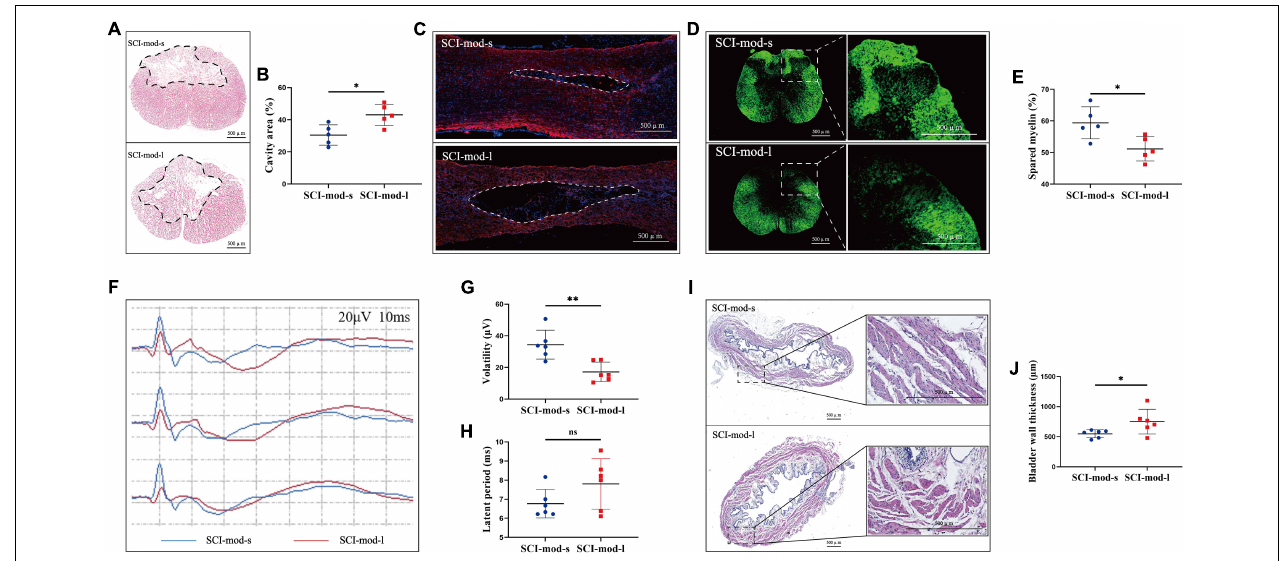
FIGURE 7 | Comparison between the SCI-mod-s group and SCI-mod-l group on (A,B) cavity region; (C) glia scar; (D,E) spared myelin; (F–H) electrophysiological detection; (I,J) thickness of bladder wall ( ∗ p < 0.05; ∗∗ p < 0.01; ns represents no statistical